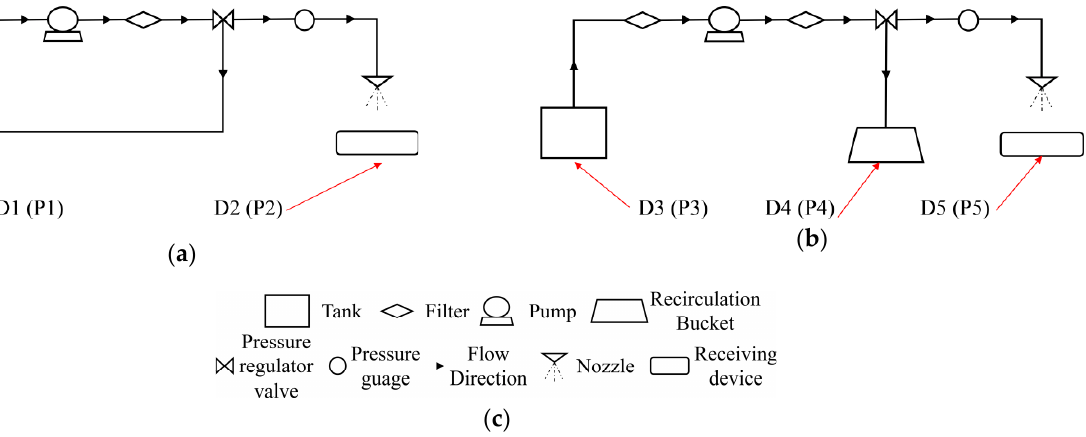
Figure 2. Tests on the influence of recirculation device on the pollen activity in pollen suspensions. ( a ) Pollen suspension recirculating into the tank. ( b ) Pollen suspension recirculating into the recir- culation bucket. ( c ) The device represented by each symbol. D1 (P1) is used to indicate the sampling position, where D1 indicates that the system uses a diaphragm pump, and P1 uses a plunger pump.